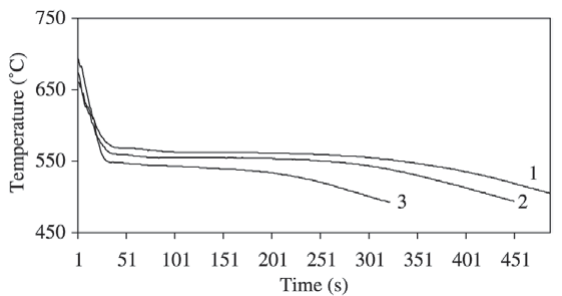
Figure 3. Correlation between cooling rate and distance from the cold end.